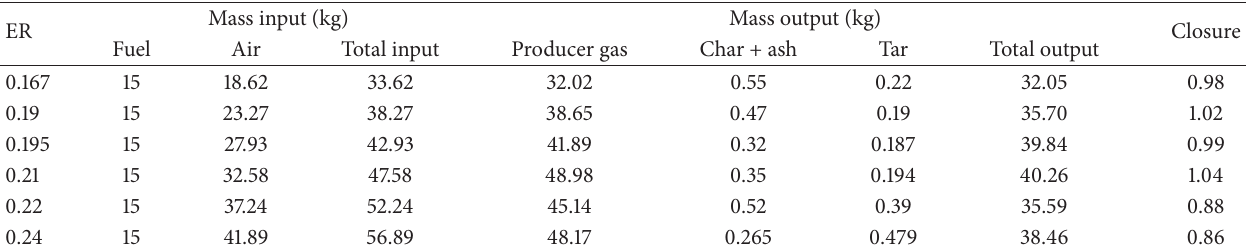
Table 2: Effect of ER on mass balance and its closure.